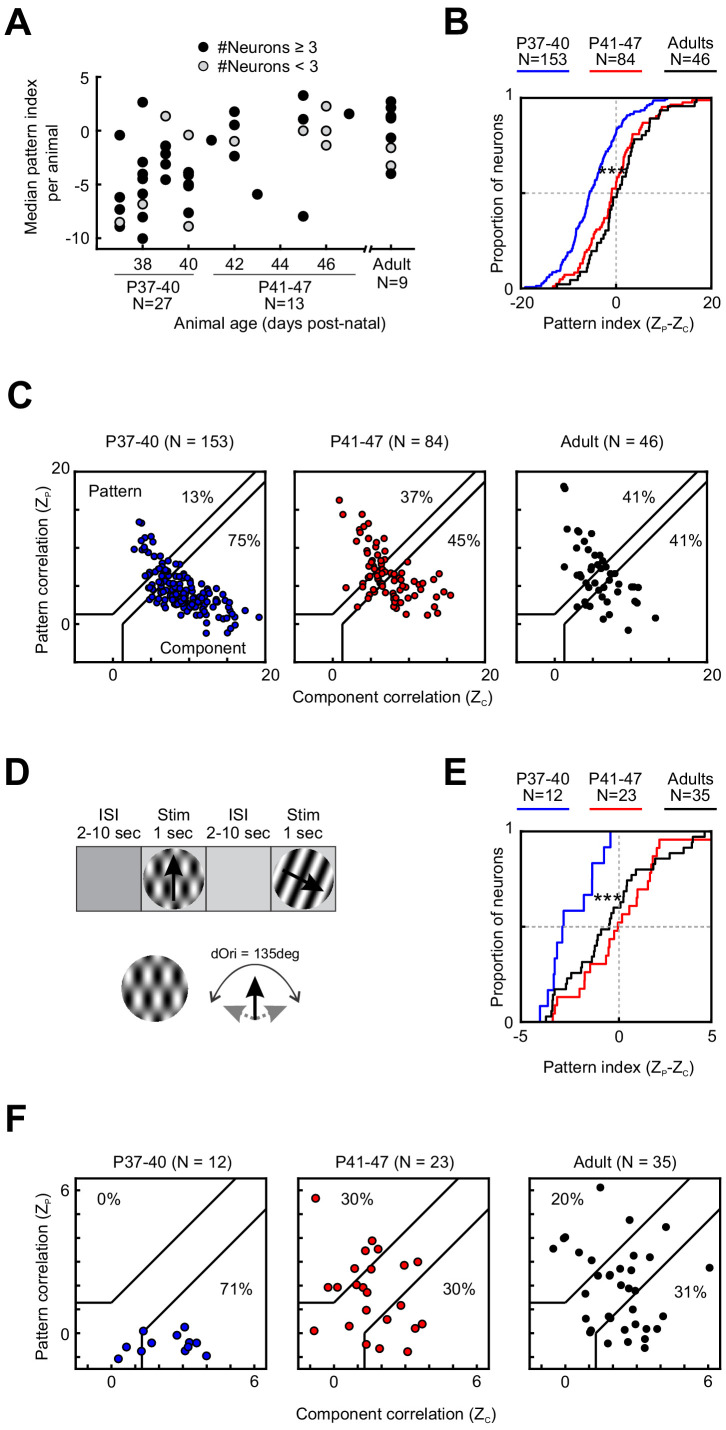
Motion integration in PSS matures around P41.(A) Median PSS pattern index for each animal included in the study, plotted as a function of age. Gray dots represent animals that yielded one to two neurons, black dots represent animals with data for at least three neurons. (B) Cumulative distributions for pattern indices in different age groups. For further information on statistical tests for this and all following plots, see Table 1. ***p<0.001. (C) Pattern versus component correlations for PSS neurons in animals from different age groups. For each neuron, ZP is plotted against ZC. Black lines indicate the category boundaries used to classify cells into pattern, unclassified, and component cells. Percentages indicate the portion of neurons falling into the component and pattern categories. (D) Top: Illustration of the classic stimulus presentation paradigm, in which stimuli were presented for 1 s, and stimulus presentations were interleaved by 2–10 s of inter-stimulus interval. Bottom: Example plaid stimulus with 135 degrees of difference between the component directions. (E) Same as (B), but for pattern indices computed from responses to plaids presented in the classic stimulus paradigm as shown in (D). ***p<0.001. (F) Same as (C), but for pattern and component correlations computed based on the classic stimulus paradigm as shown in (D).Figure 2—source data 1.Neuron-by-neuron metrics for Figure 2 and Figure 2—figure supplement 1.